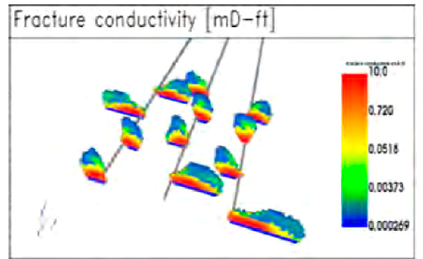
Figure A1. Perspective view of 3-well fracture creation model in low-perm matrix model, accounting for stress shadowing, leading to asymmetric hydraulic fracture development. The middle well is Well 2H with fracture conductivity used as base case inputs for the ResFrac production forecast curves of Figures A2 and A3.